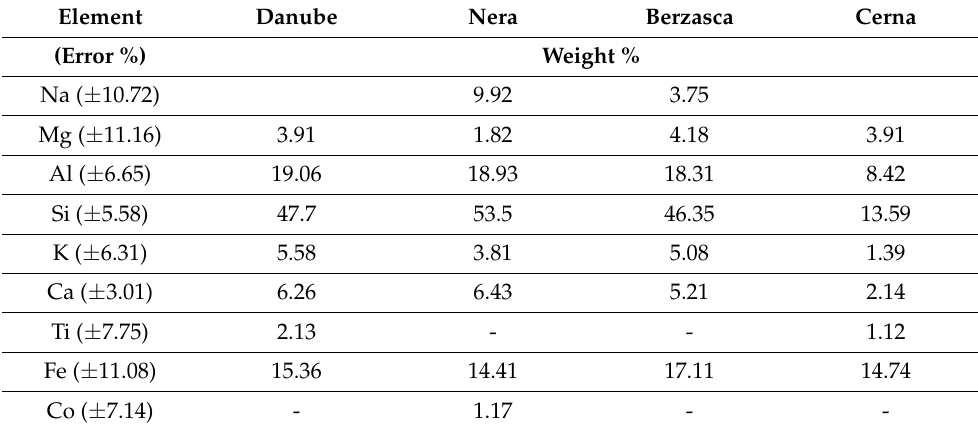
Table 5. EDAX APEX results on sediment samples.